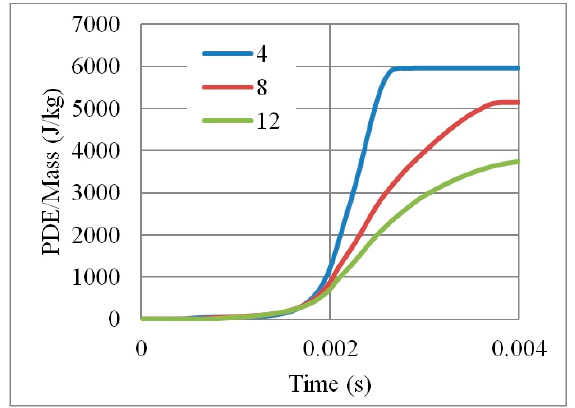
Figure 18. PDE with respect to time, for auxetic cores of different number of layers, having the same geometrical properties and loading conditions, L = 10 mm, t = 2.6 mm, t/L = 0.26, cell angle = 60°, AL3.